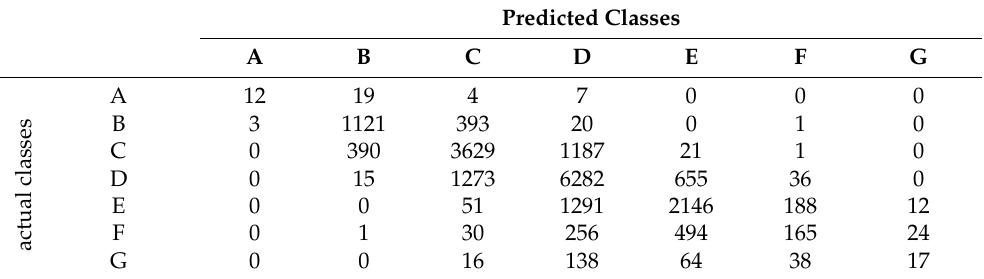
Table 7. Confusion matrix for